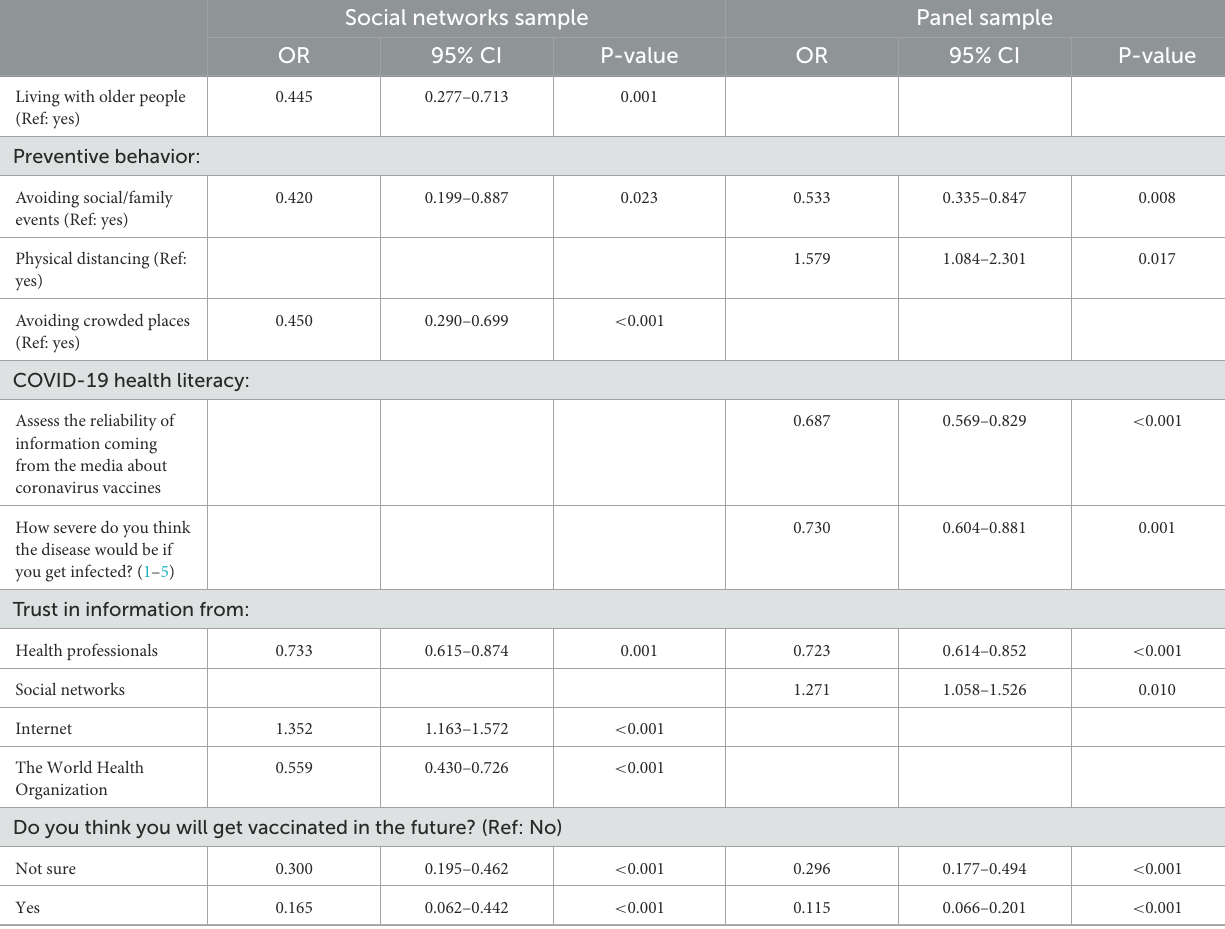
TABLE 4 Logistic regression models for factors associated to belonging to Cluster 2, in each